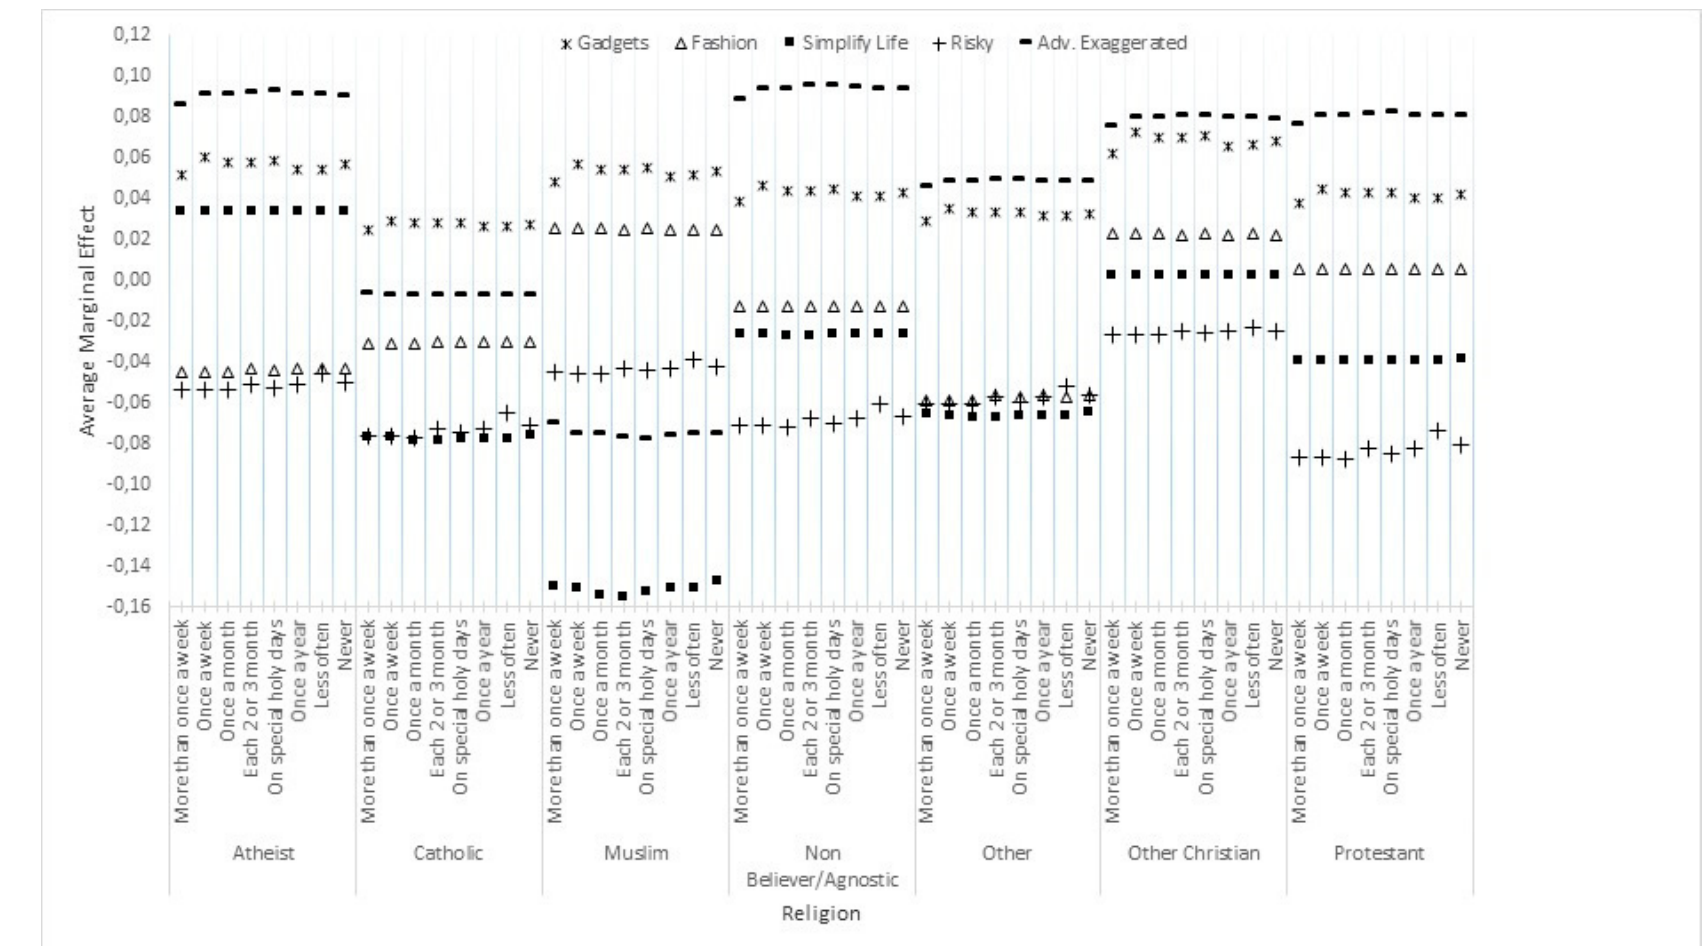
Figure 2. Logit marginal effects. Innovative products as gadgets, fashion, simplify life, risky and advantages exaggerated vs. religion/religiosity.